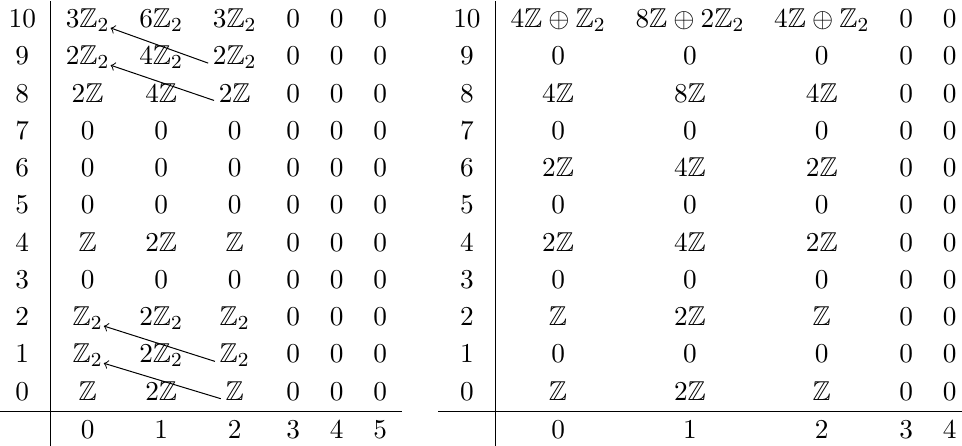
( T 2 ) (left) and Ω Spin c ( T 2 ) (right). n n